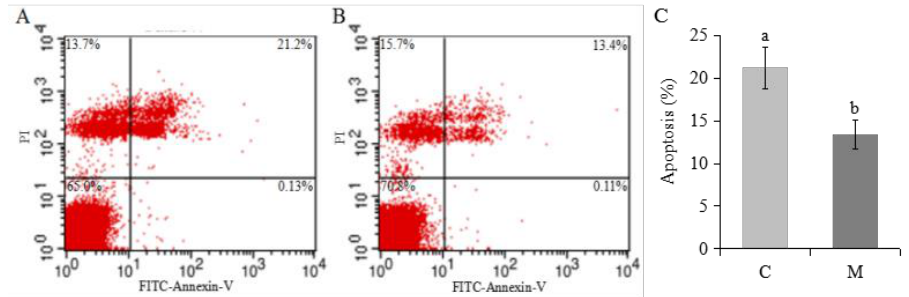
Figure 3. Effects of melatonin on cumulus cells apoptosis. Flow cytometry ( A : C group; B : M group); mean ± SEM cumulus cells apoptosis ( C ). The experiment was repeated three times; Data presented as mean ± SEM; a,b in Figure 3C, for columns, means without a common superscript differed ( p < 0.05 ).